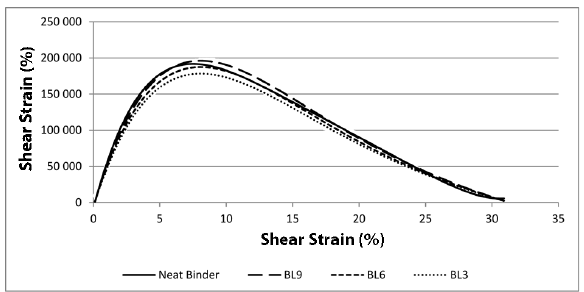
Fig. 7. Stress-Strain curves extracted from LAS testing of limestone modified binders